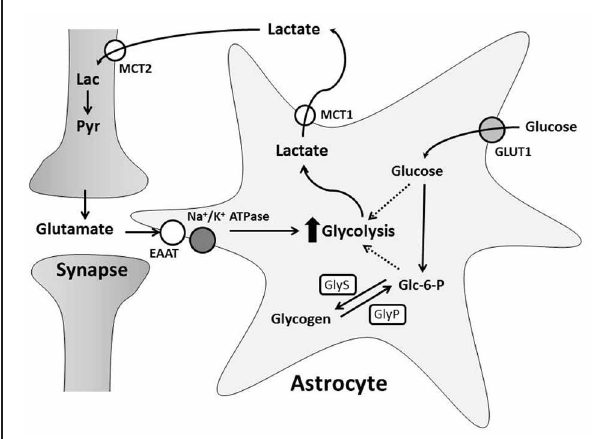
FIGURE 2 | The Astrocyte to Neuron Lactate Shuttle Hypothesis. Free glucose is taken up by astrocytes through GLUT1 transporters and converted to glucose-6-phosphate (Glc-6-P). Glc-6-P is stored as glycogen synthesized by glycogen synthase (GlyS). During greater energy demand, glycogenolysis, mediated by glycogen phosphorylase (GlyP), creates Glc-6-P for glycolysis. Synaptic transmission induces astrocyte glycolysis and lactate production through glutamate uptake. This increases glucose consumption and/or glycogen breakdown in astrocytes. Astrocyte lactate is transported into the extracellular space by MCT1 and taken up through MCT2 by neurons. Neurons can convert lactate (Lac) to pyruvate (Pyr) for oxidative